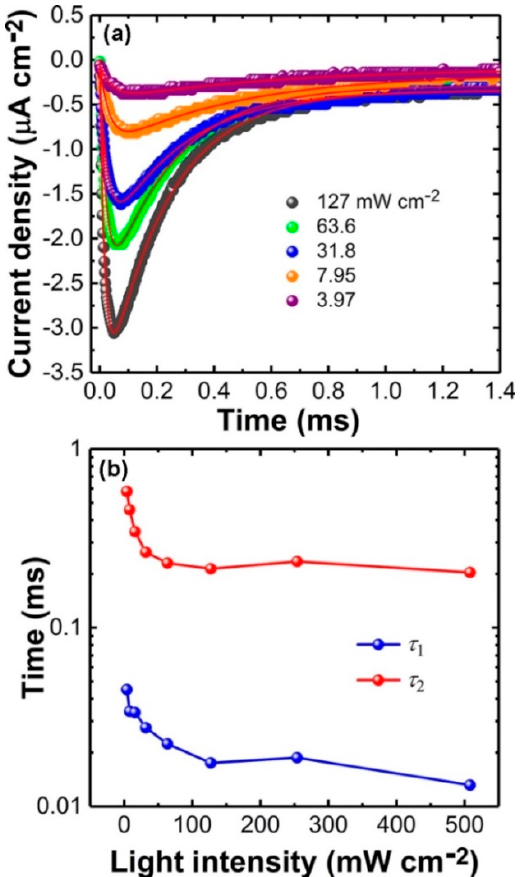
Figure 4. Analyses for the “OFF” photocurrent transients from a ITO/PVDF/ZnPc:C 60 /Al device. ( a ) The “OFF” photocurrent transients after light illumination with different light intensity. Theoretic simulations (red curves) fit the experimental data well. ( b ) Decay time τ 1 (blue points) and τ 2 (red points) at different light intensity can be extracted.